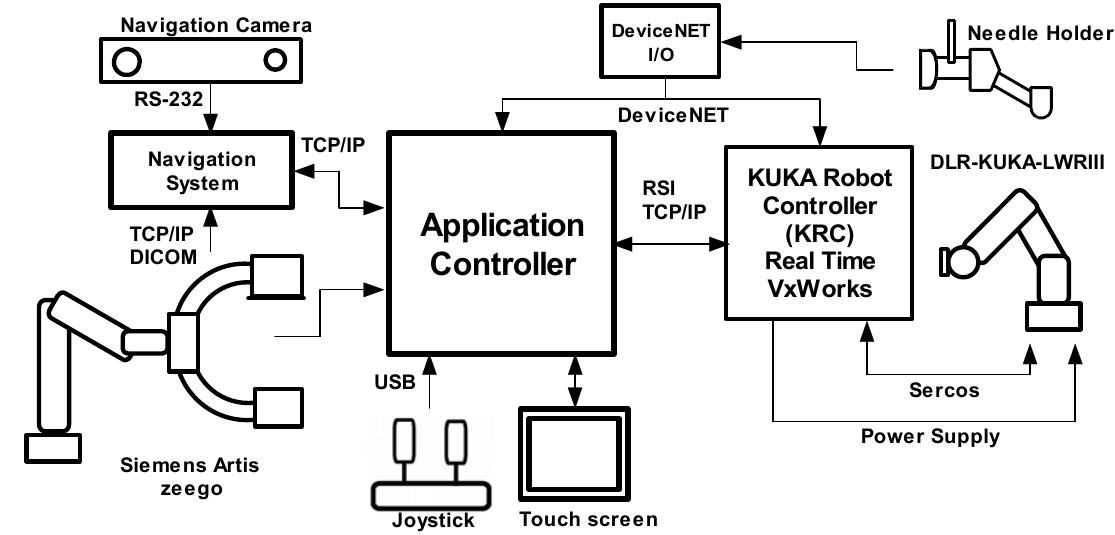
Figure 5. Control architecture. The application controller receives information from the different components of the system and uses it to control the robot